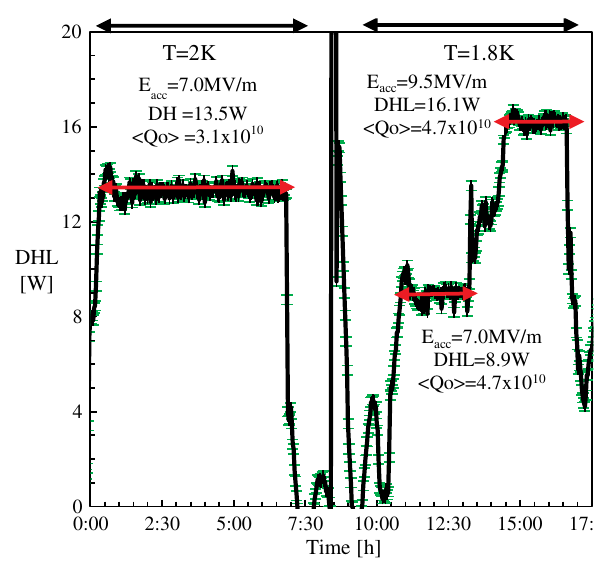
¼ FIG. 10. DHL for E acc (right). Reference for E